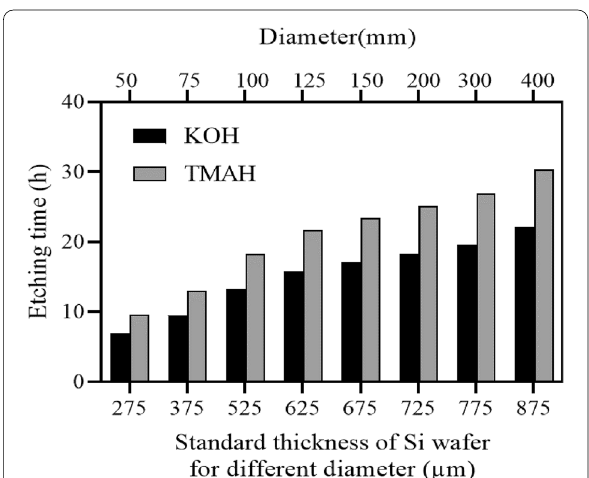
Fig. 4 Etching time to form through holes in different